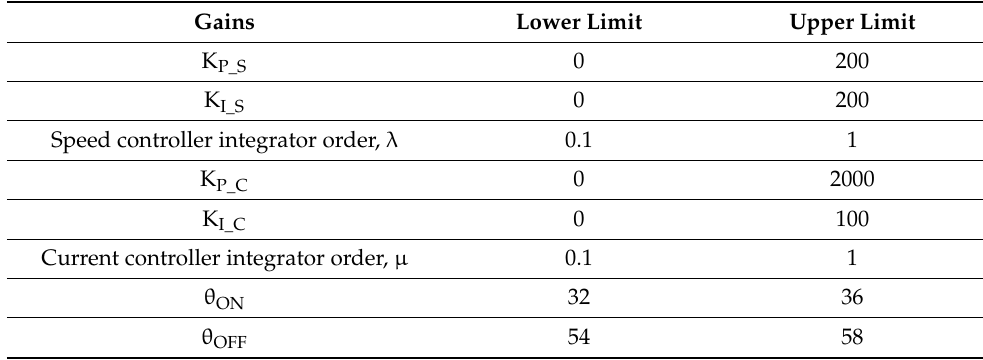
Table 7. Range of gains adopted for CamAO FO-PI controller, commutation angle